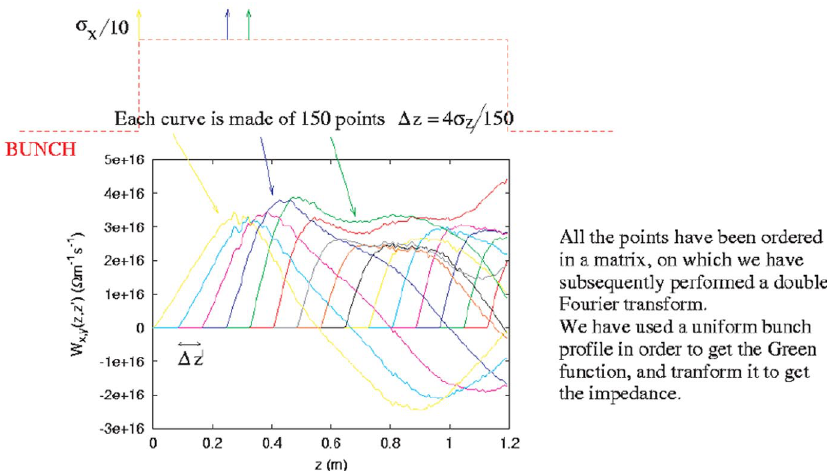
FIG. 74. (Color) Two-dimensional wakefield simulated by Rumolo [91] for a uniform bunch profile in the CERN SPS using the HEADTAIL code; displacing different bunch slices gives rise to nonidentical wakefields that enter into the Fourier transform for the two- dimensional impedance; the bunch head is on the left.